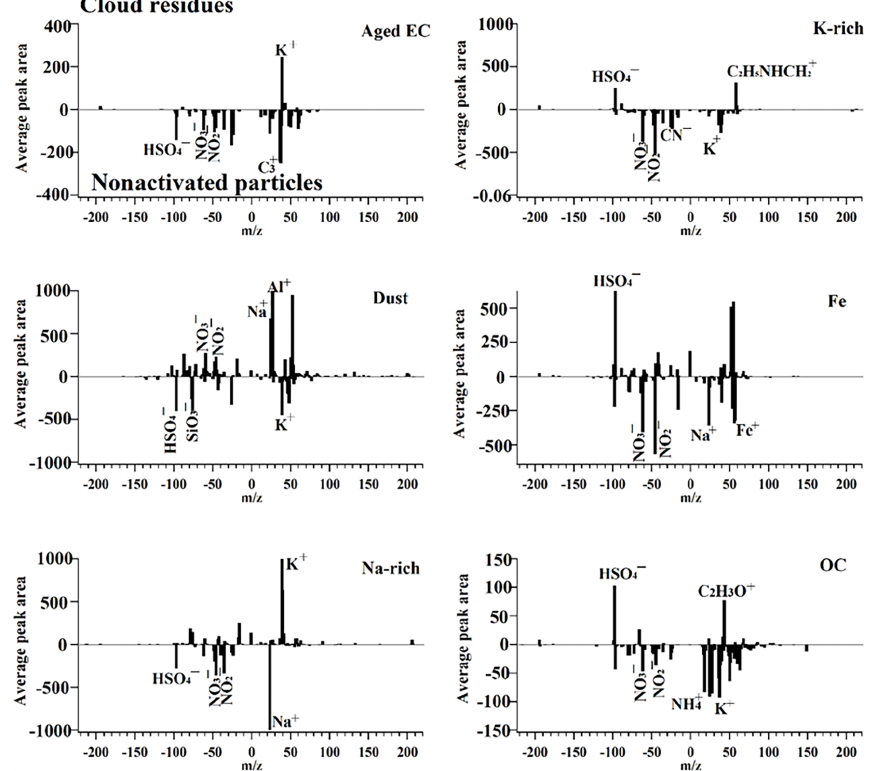
Figure 9. Mass spectral subtraction plot of the average mass spectrum corresponding to cloud residues minus nonactivated particles. Positive area peaks correspond to higher abundance in cloud residues, whereas negative area peaks show higher intensity in nonactivated